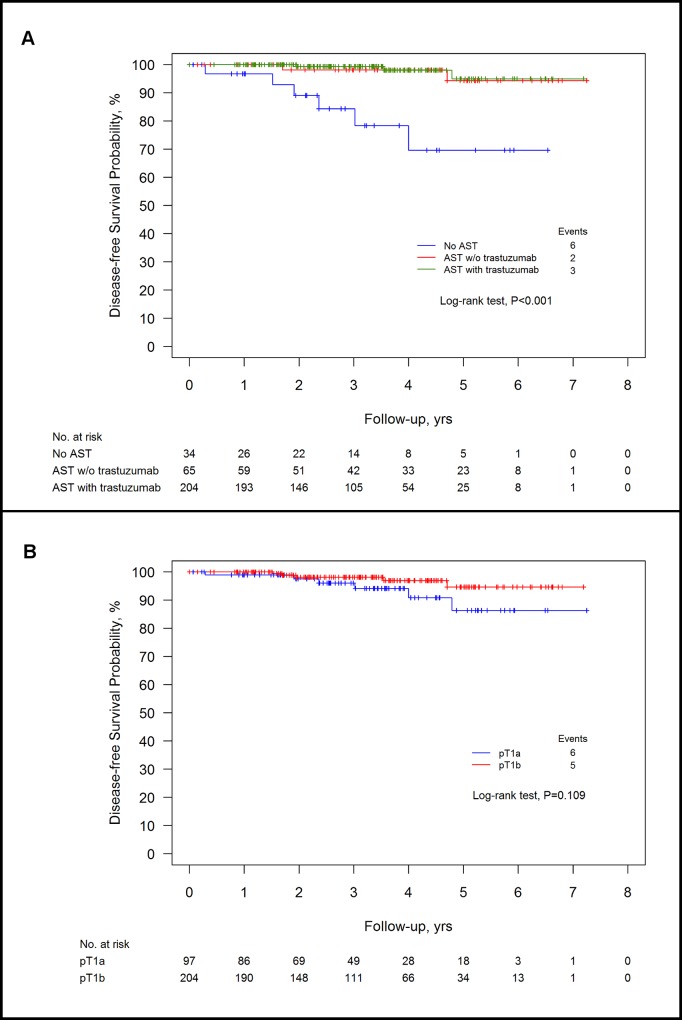
A. Disease-free survival according to treatment group. Fig 1A shows Kaplan Meier’s disease-free survival curves according to treatment group. B. Disease-free survival according to stage. Fig 1B shows Kaplan Meier’s disease-free survival curves according to stage; the analysis was performed on 301 patients, since data on stage were missing for 2 patients.